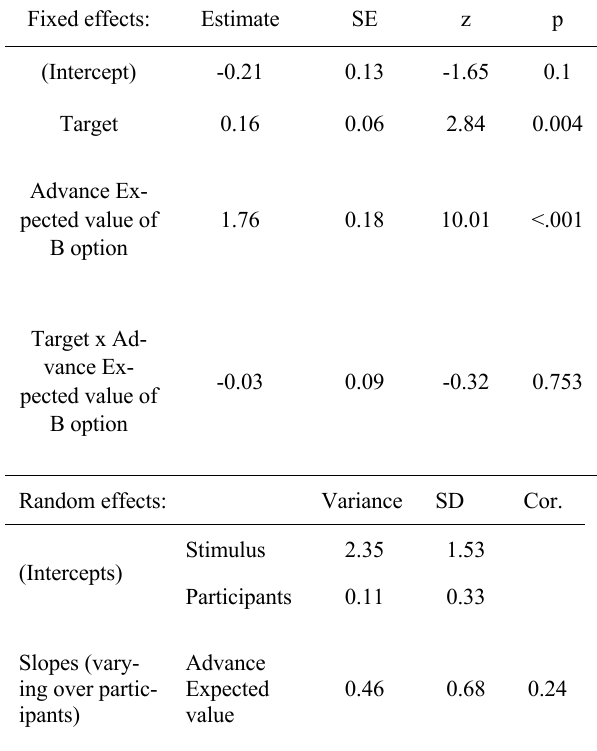
Table 1. Generalize linear mixed model predicting final